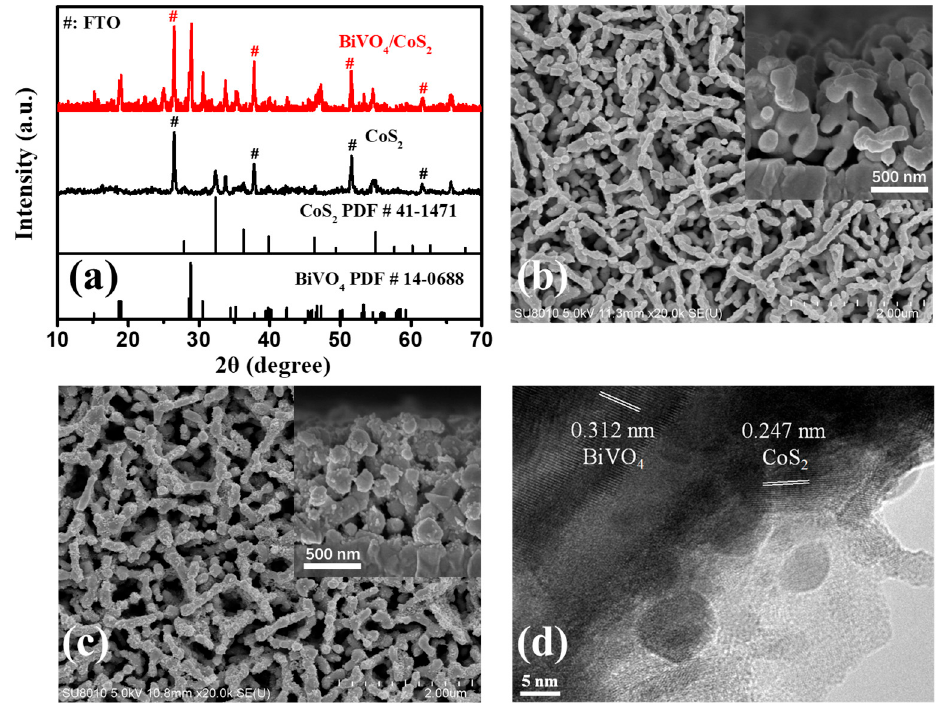
Figure 1. ( a ) XRD of CoS 2 and BiVO 4 /CoS 2 . ( b ) SEM image of bare BiVO 4 , inset: cross-section image of bare BiVO 4 . ( c ) BiVO 4 /CoS 2 , inset: cross-section image of BiVO 4 /CoS 2 . ( d ) HRTEM image of BiVO 4 /CoS 2 .